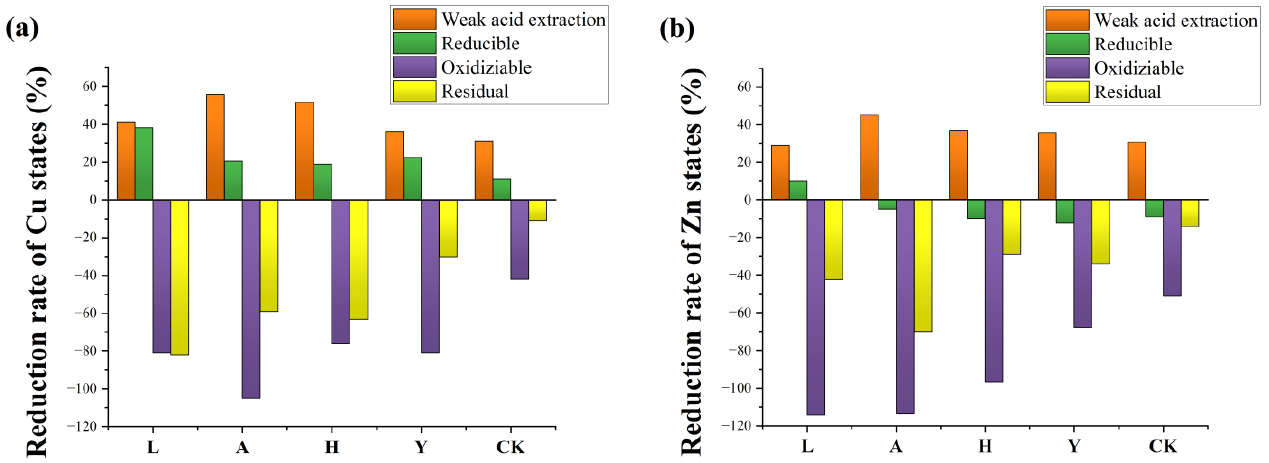
Figure 5. Reduction rates of various forms of ( a ) Cu and ( b ) Zn after different inorganic passivation treatments.